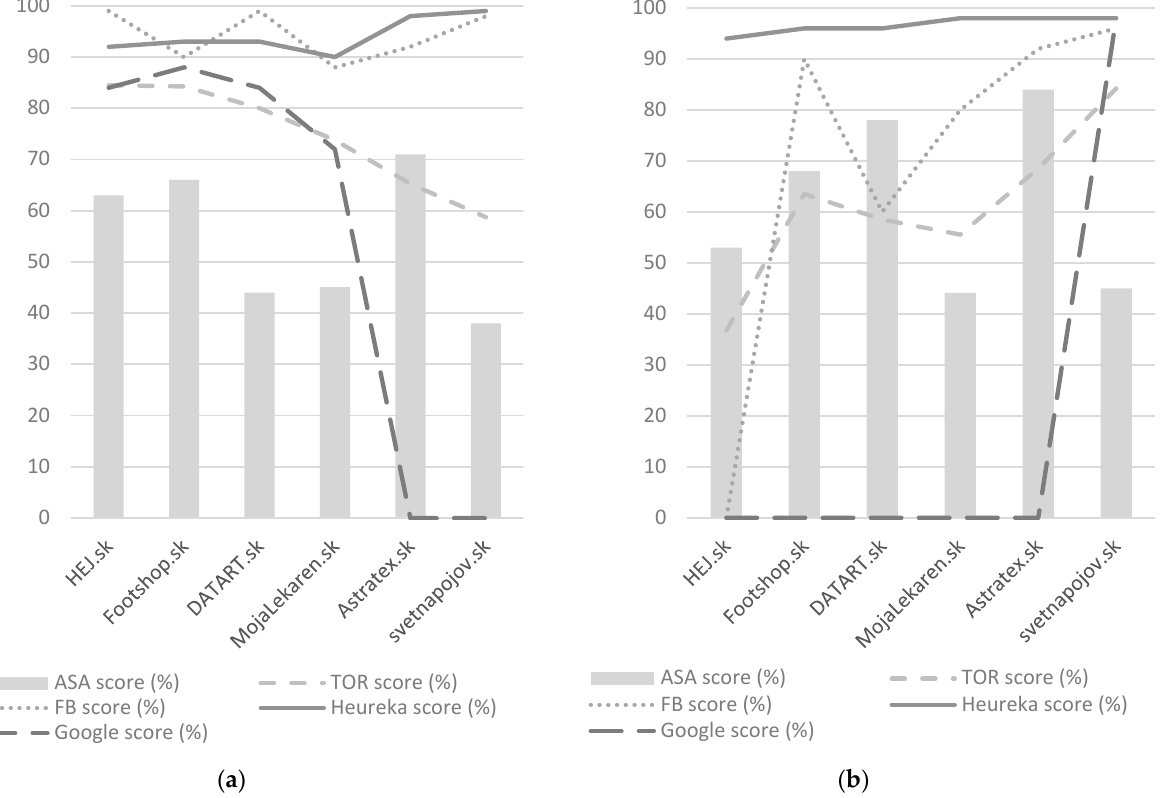
Figure 4. Interpretation of selected relationships: ( a ) 2020; ( b ) 2022.